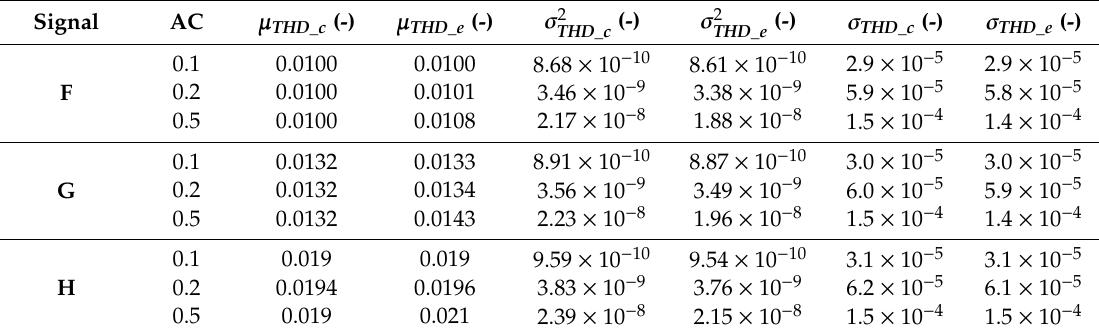
Table 9. Results of the test vs. harmonic amplitude, all at 0.5% of the 50 Hz component. Signal